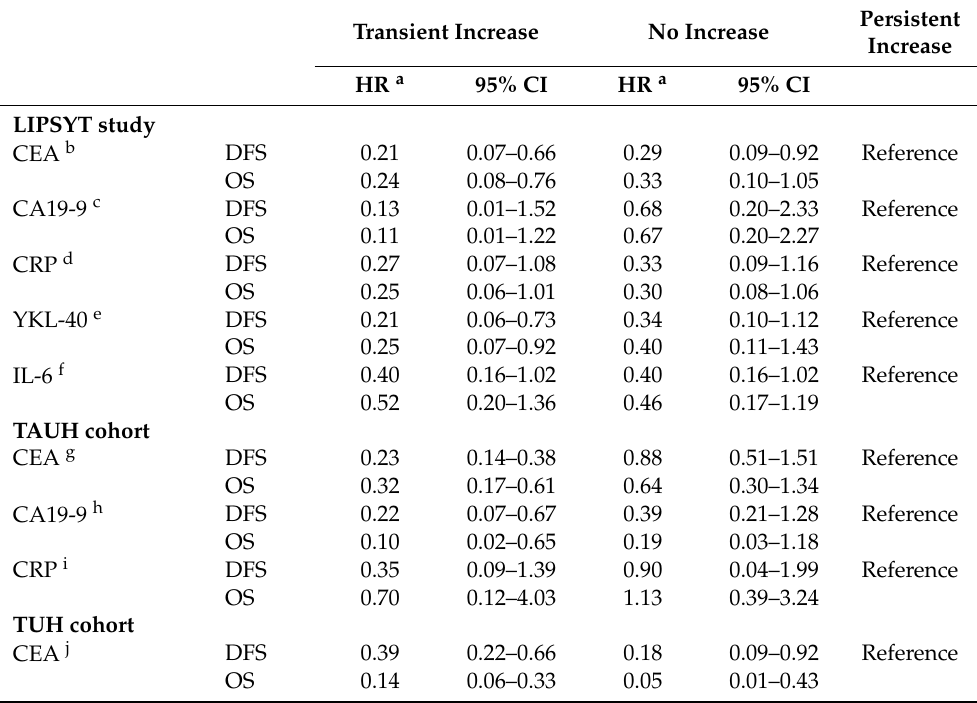
Table 4. Disease-free survival (DFS) and overall survival (OS) according to biomarker dynamics within reference during adjuvant therapy. Adjusted hazard ratio (HR) and 95% confidence interval (CI), with persistent increase in biomarker level used as reference groups. Persistent Transient Increase No Increase Increase HR a 95% CI HR a 95% CI